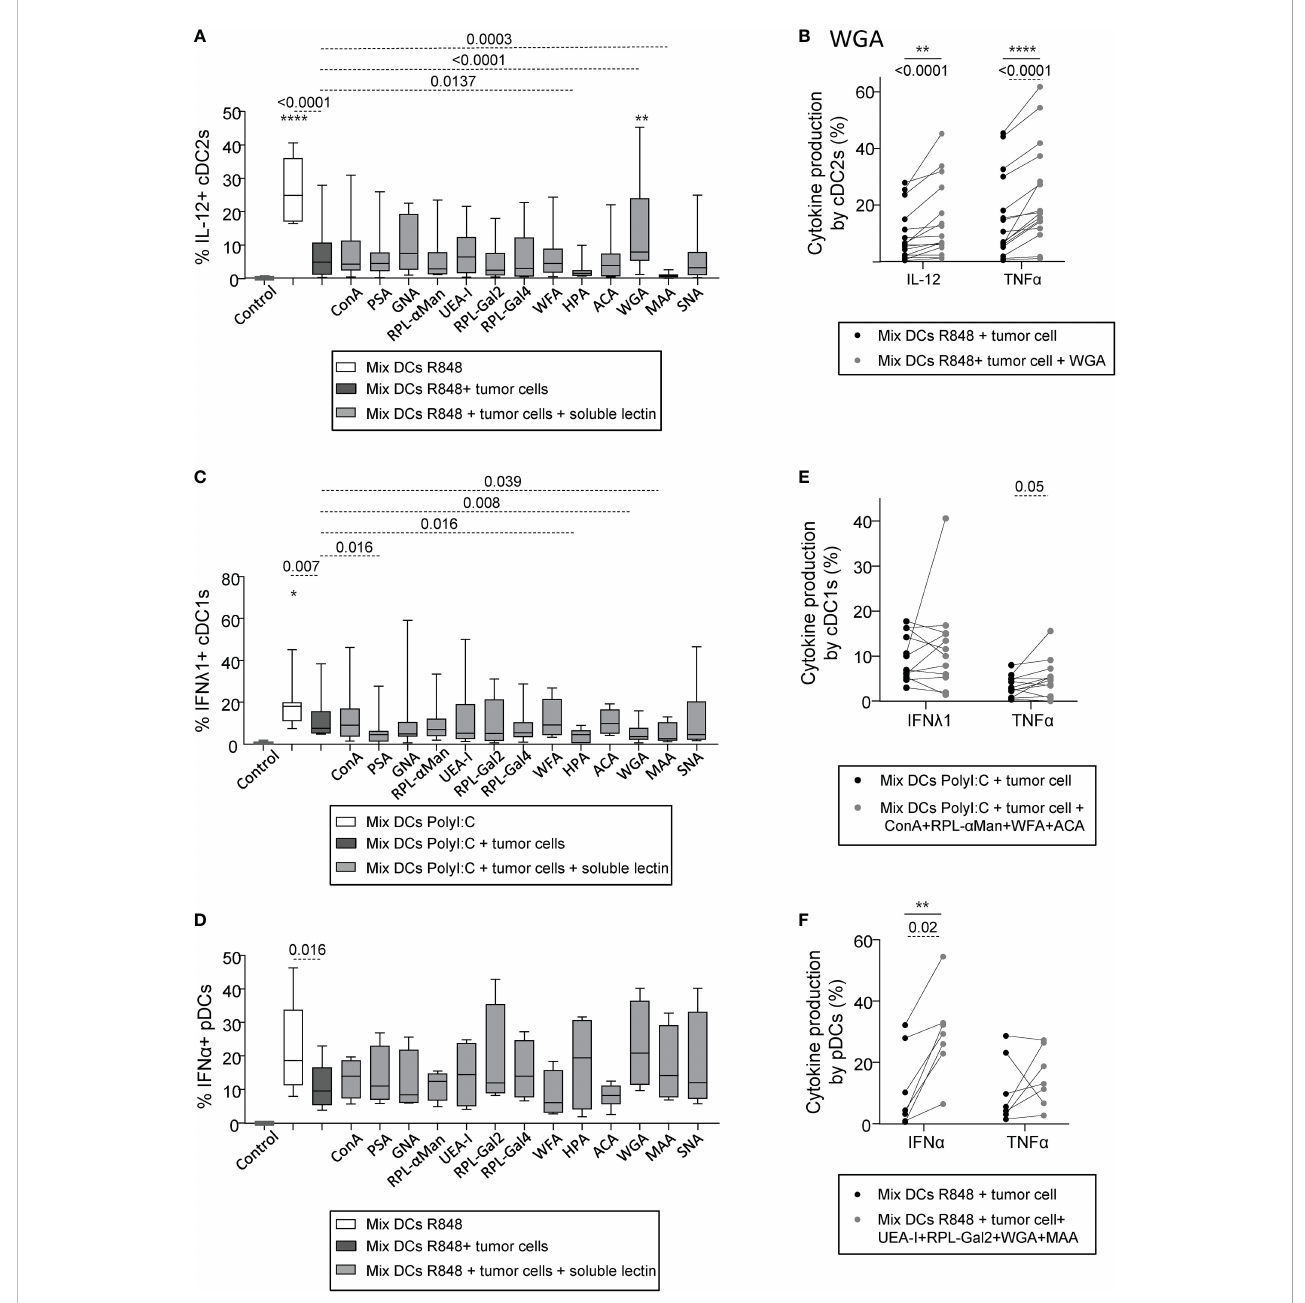
FIGURE 6 Pre-treatment of “ negative ” tumor cells with speci fi c lectins in-vitro reverses their damaging impact on cDC2s and pDCs ’ cytokine production. PanDCs were puri fi ed from several HD blood (n=12) and co-cultured for 20 hours with distinct tumor cell lines (n=12) previously cultured or not with single or mixture of soluble lectins for 2 hours. Collected panDCs were then stimulated for 5 hours with or without TLR-L and cytokine production was assessed by intracellular cytokine staining. (A) Frequencies of IL-12p40/p70 + cDC2s upon R848 after culture (gray and black bars) or not (white bars) with tumor cells previously treated (gray bars) or not (black bars) with single soluble lectins (n = 11 to 20 cocultures per group including 12 tumor lines and 12 HDs). (B) Proportions of cytokine-producing (IL-12p40/p70 and TNF a ) cDC2s upon R848 stimulation after culture with tumor cell lines treated (gray circles) or not (black circles) with WGA (blocks mostly GlcNAc and NeuAc residues) (n = 16 cocultures per group including 12 tumor lines and 12 HDs). (C, D) Proportions of IFN l 1 + cDC1s upon PolyI:C stimulation (C) (n = 8 to 12 cocultures per group including 8 tumor lines and 7 HDs) and of IFN a + pDCs upon R848 stimulation (D) (n = 4 to 7 cocultures per group including 5 tumor lines and 10 HDs) after culture (gray and black bars) or not (white bars) with “ negative ” tumor cell lines previously treated (gray bars) or not (black bars) with single soluble lectins. (E) Proportions of cytokine-producing (IFN l 1 and TNF a ) cDC1s upon PolyI:C stimulation after culture with “ negative ” tumor cell lines treated (gray circles) or not (black circles) with a mixture of lectins containing ConA, RPL- a Man, WFA and ACA (n = 12 cocultures per group including 6 tumor lines and 6 HDs). (F) Frequencies of cytokine- producing (IFN a and TNF a ) pDCs upon R848 stimulation after culture with “ negative ” tumor cell lines treated (gray circles) or not (black circles) with a mixture of lectins containing UEA-I, RPL-Gal2, WGA and MAA (n = 7 cocultures per group including 7 tumor lines and 7 HDs). (A-F) Results are expressed as percentages of cytokine-expressing cells within each group. Interleaved box and whiskers representation plotting were from minimum to maximum. “ Control ” represents the condition mix DCs alone (without tumor, without lectin, without TLR-L). Only signi fi cant statistics are shown. P -values were calculated using both matched two-way repeated measures ANOVA (full lines) or mixed-effects model (REML; stars) with Bonferroni ’ s multiple comparisons test, and/or Wilcoxon matched-paired signed rank test (dashed lines). Stars represent a signi fi cant difference between the given group and the condition “ Mix DCs + tumor cells ” . *P-value ≤ 0.05, **P-value ≤ 0.01, ****P-value ≤